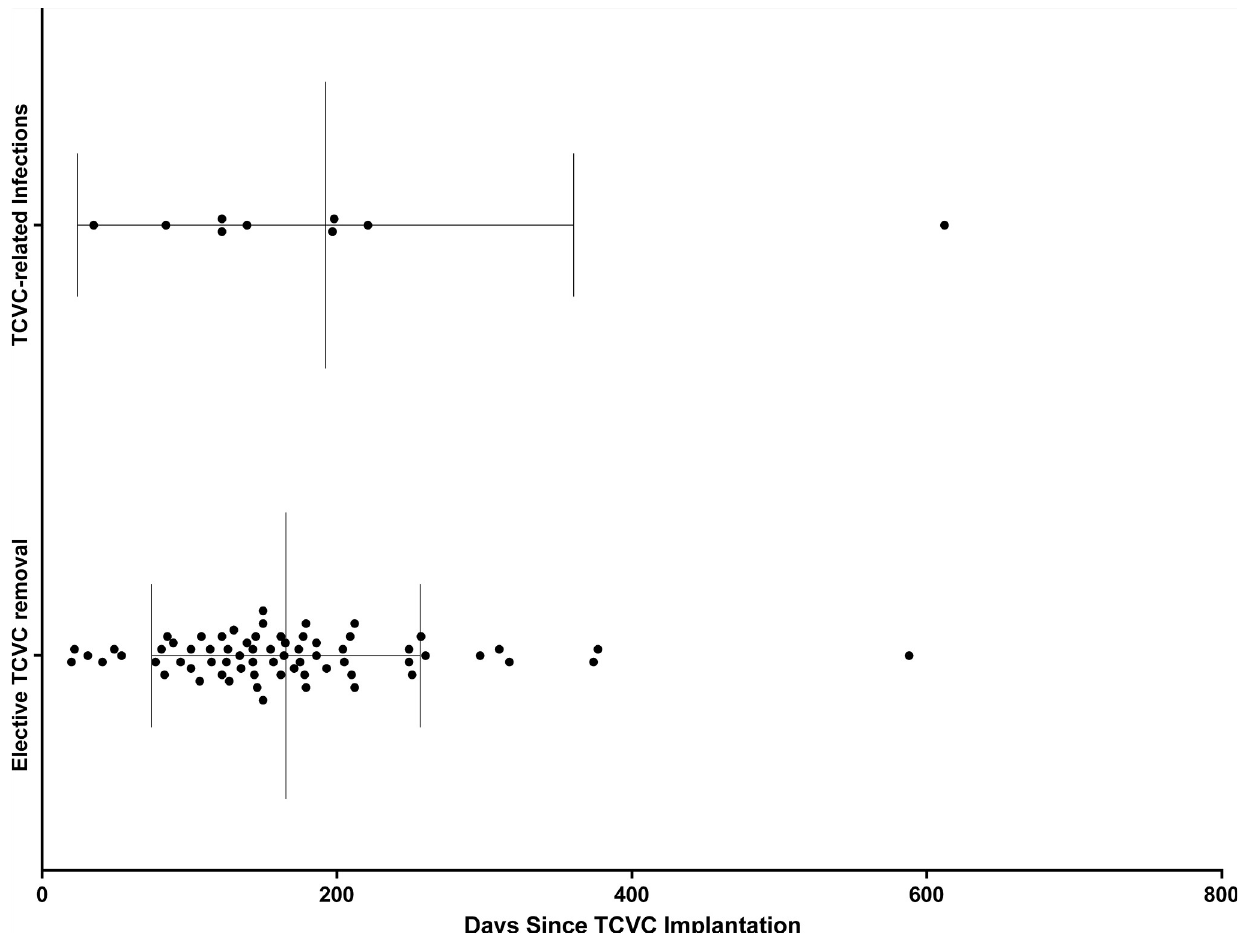
Fig 1. Elective catheter explantation in patients who completed therapy compared with patients experiencing TCVC-related infections necessitating catheter revision or premature explantation.